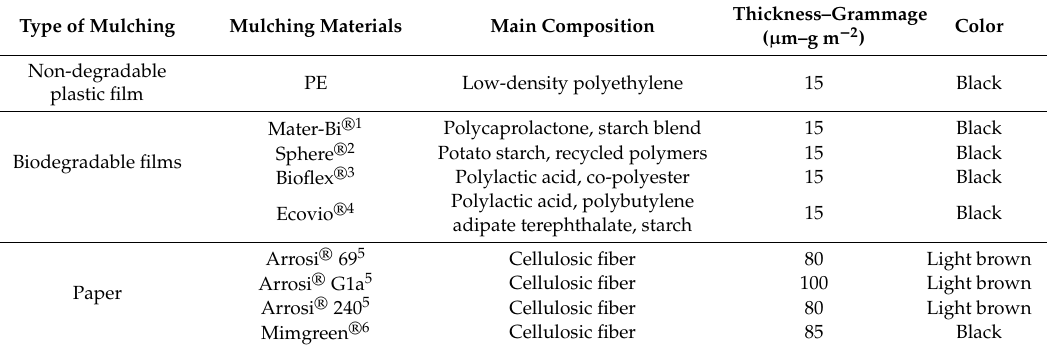
Table 2. Type, name, main composition, thickness ( µ m) (plastic films) or grammage (g m − 2 ) (paper mulches), and color of materials used in the